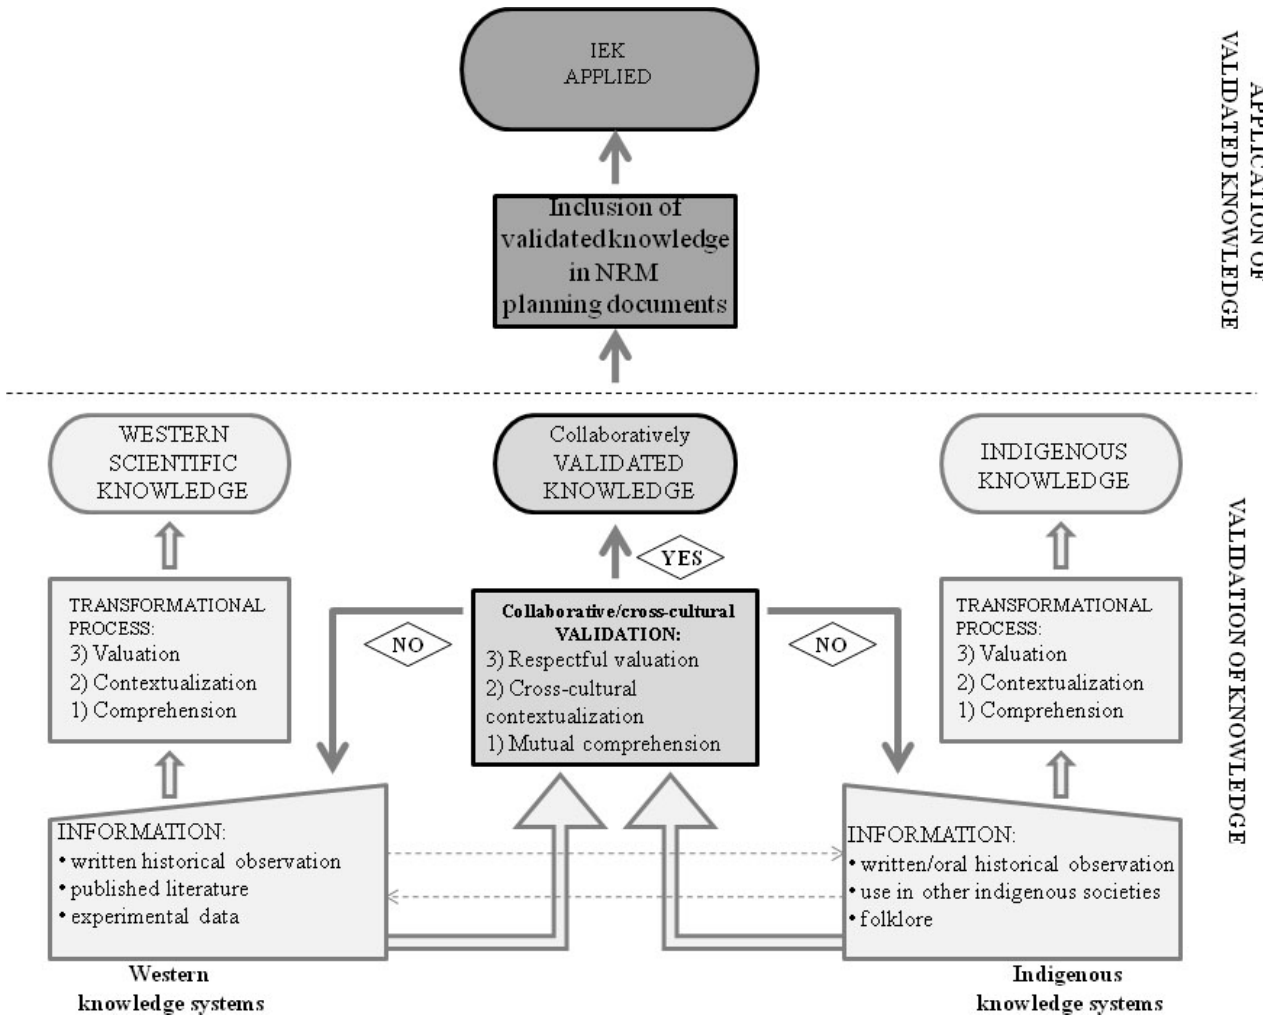
Fig. 3. A framework for collaborative validation of indigenous ecological knowledge (IEK). In the diagram trapezoid shapes represent ‘inputs’ to processes, squares represent ‘processes’ and rounded shapes represent ‘outputs.’ Dashed arrows represent potential independent accessing of information by western and indigenous knowledge systems outside a collaborative validation